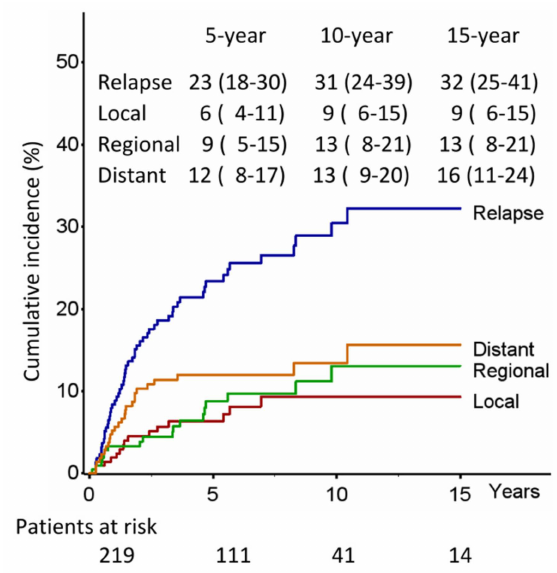
Figure 3. Lung cancer recurrence.